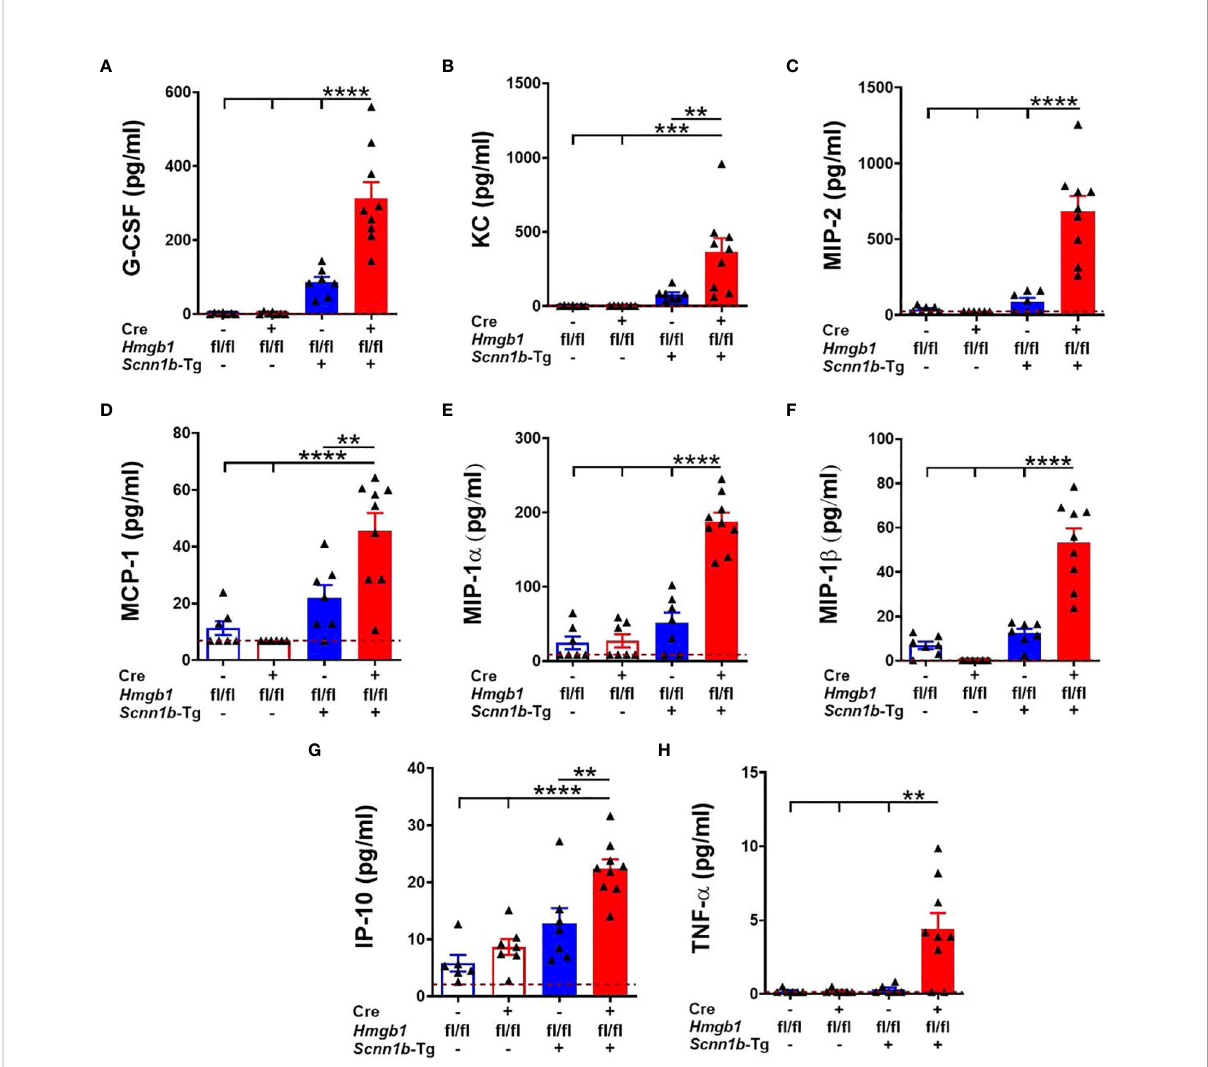
FIGURE 5 Airway epithelial cell-speci fi c deletion of HMGB1 alters the levels of in fl ammatory mediators in the airspaces of Tg+ mice. Cell-free BALF cytokine levels (picograms per milliliter) of G-CSF (A) , KC (B) , MIP-2 (C) , MCP-1 (D) , MIP-1 a (E) , MIP-1 b (F) , IP-10 (G) , and TNF- a (H) in WT mice (with Cre - or Cre + status) and Tg+ mice (with Cre - or Cre + status) are shown. Red dotted horizontal lines indicate the lower limit of detection (LOD) obtained in the assay. The values that were below the LOD were assigned value 0.01 unit less than the LOD. Sample size n=7-9/group. Error bars represent Mean ± SEM. One-way ANOVA followed by Tukey ’ s post hoc test was used for the statistical analysis. ** p < 0.01, *** p < 0.001, **** p <